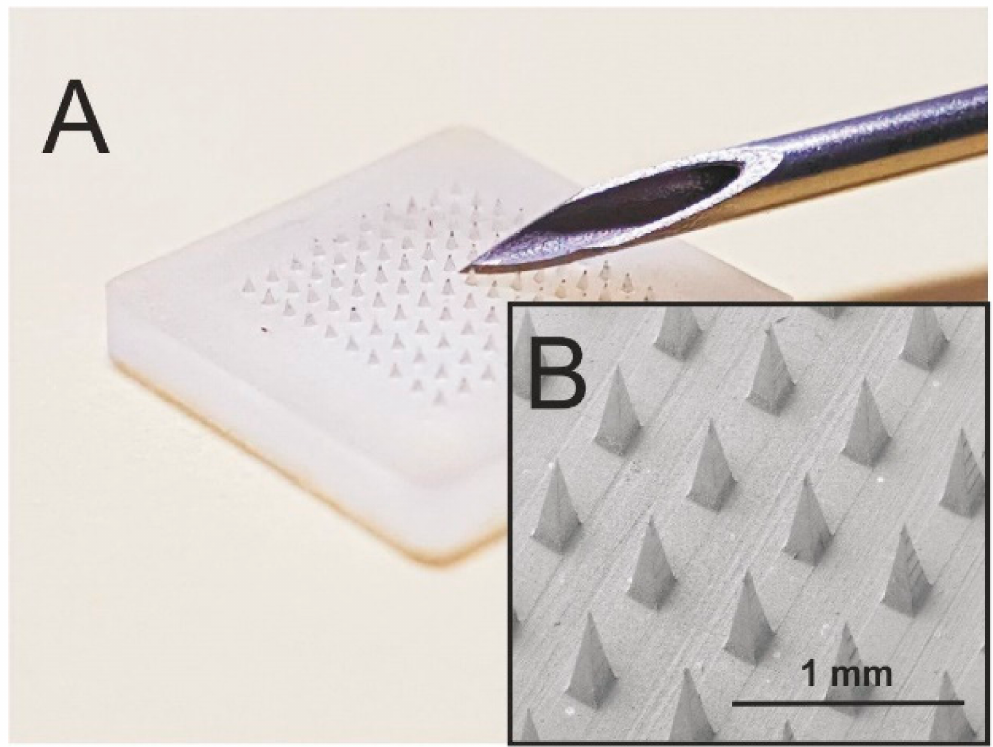
Figure 3. ( A ) Comparison of a microneedle patch (200 × 200 × 350 µ m) with a standard hollow-bore needle. ( B ) Electron micrograph of the polystyrene microneedle